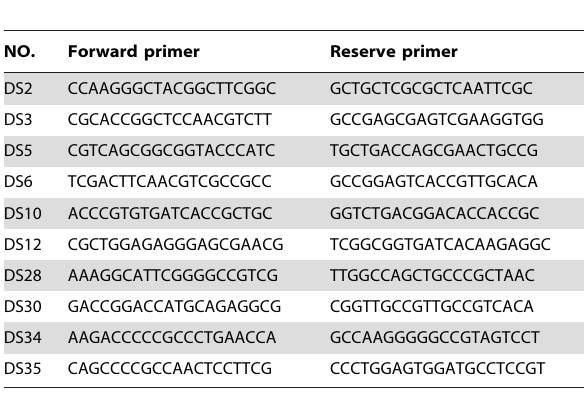
Table 8. The qRT-PCR primers of 10 larval stage specific